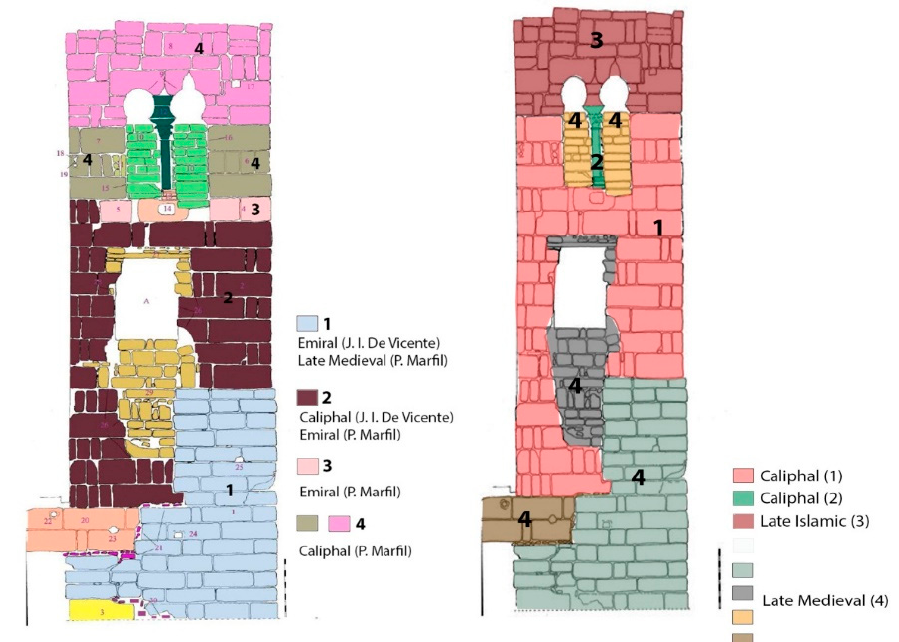
Figure 3. Drawing of the southern face of San Lorenzo minaret (basis from Marfil 2010, p. 55, lám. 5, used with his permission. Colors are added by author according to the different interpretations given to the minaret). To the left side, interpretations by De Vicente (2014, p. 145) and Marfil (2010, p. 55). To the right side, author’s own interpretation.